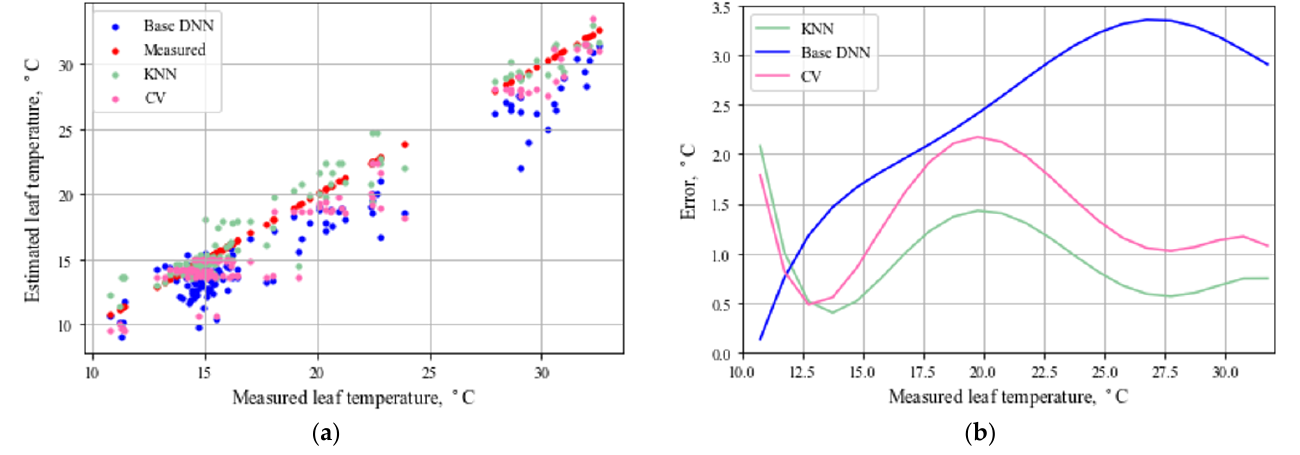
Figure 7. Using high-correlated features: ( a ) KNN, BASE, and CV leaf temperature predictions versus the measured values; and ( b ) each model error as a function of the measured values.